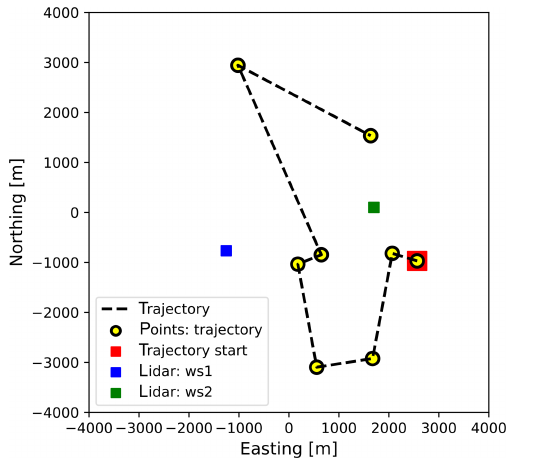
Figure 12. Final campaign design for Italian site.